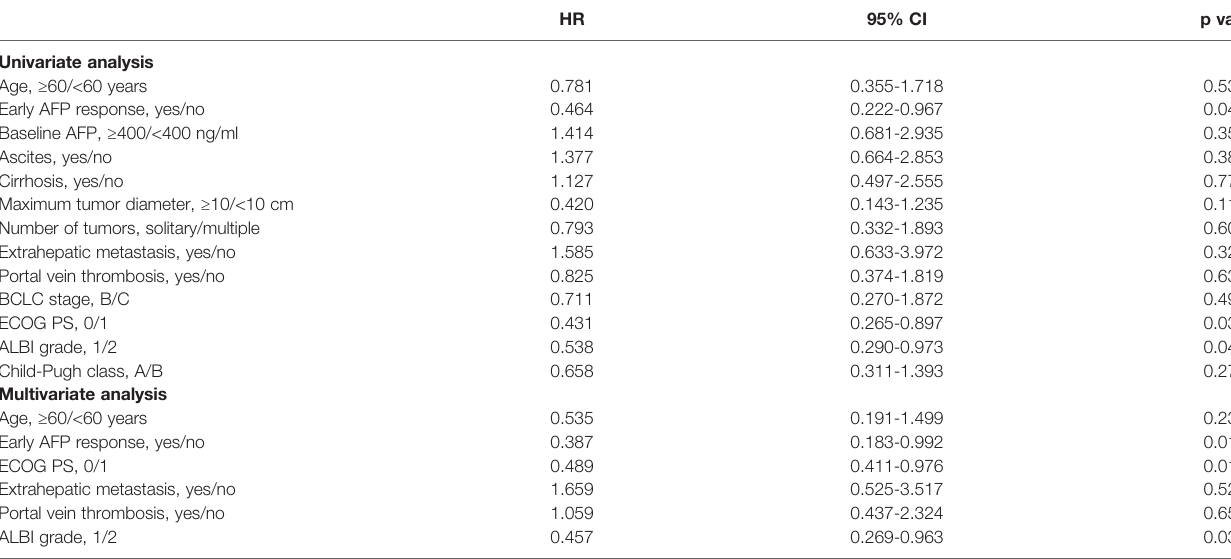
TABLE 3 | Univariate and multivariate analysis for PFS.